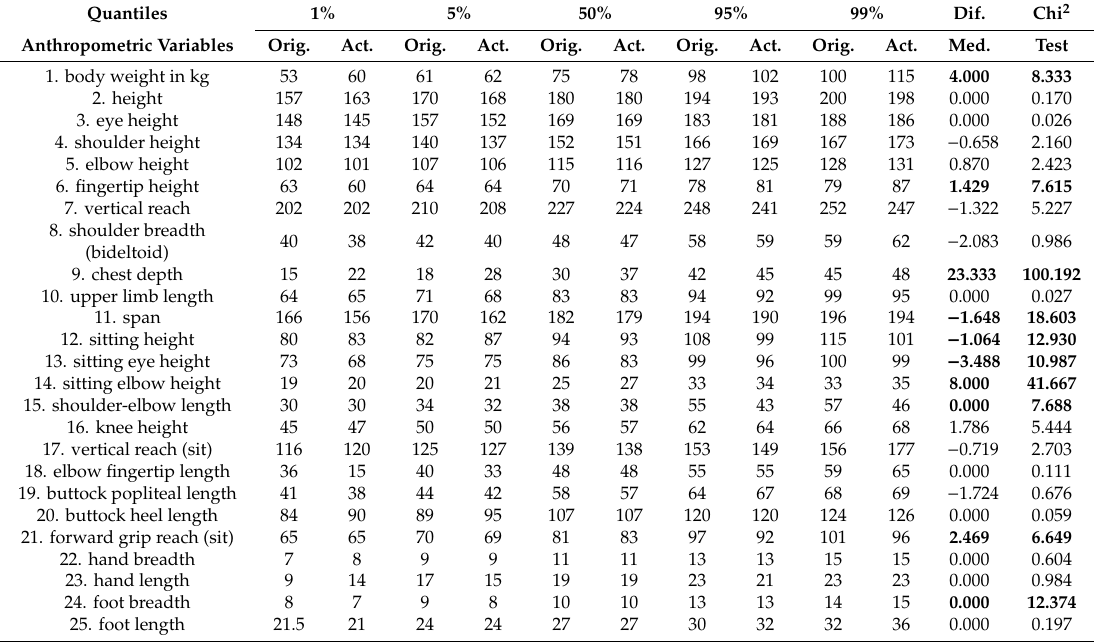
Table 8. Comparison of the original (the year 2004) and actual (the year 2018) quantiles of selected anthropometric variables of the male population in the Czech